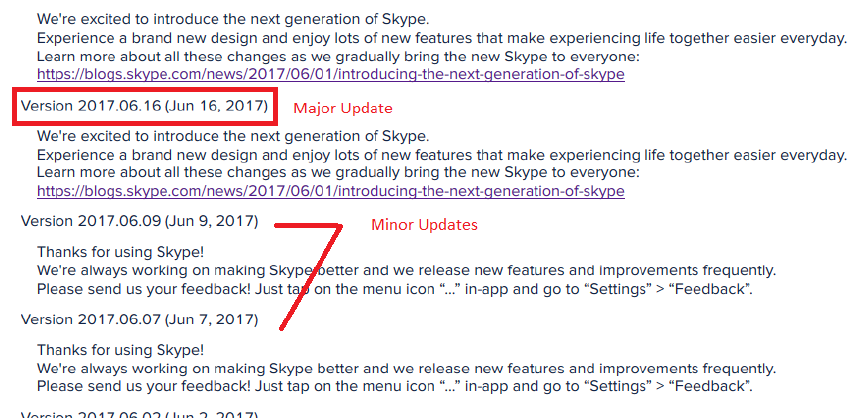
Figure 5. Examples of major and minor